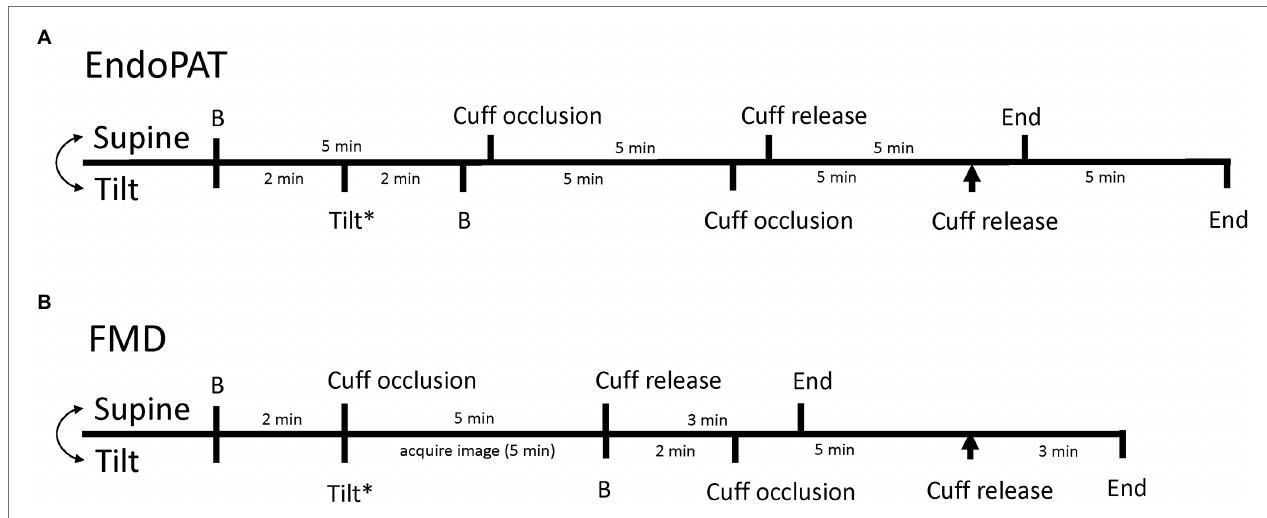
FIGURE 1 | Timeline of data collection for EndoPAT trials (A) and flow-mediated dilation (FMD) trials (B) . The timelines for the supine trials are on the top of each line and the timeline for the tilted trials are on the bottom of each line. The double headed arrow indicates that the supine and tilted trials are randomized. B Indicates baseline, the asterisk highlights the time of upright tilt, and the arrowhead indicates the time of reactive hyperemia/cuff release during